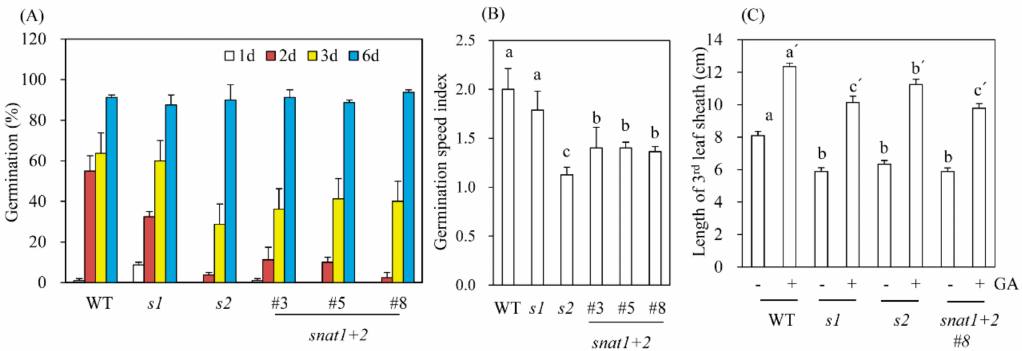
Figure 5. Germination rates, speeds, and increases in leaf sheaths after GA 3 treatments. ( A ) Time–course experiment of germination rates. ( B ) Germination speed index. ( C ) Length of third-leaf sheaths in response to 10 µ M GA 3 . Germination rates were measured at the indicated number of days following